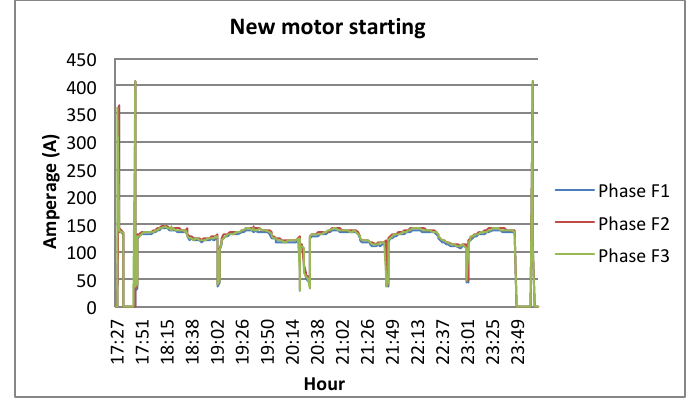
Figure 6. Trend of energy absorption of the new motor.